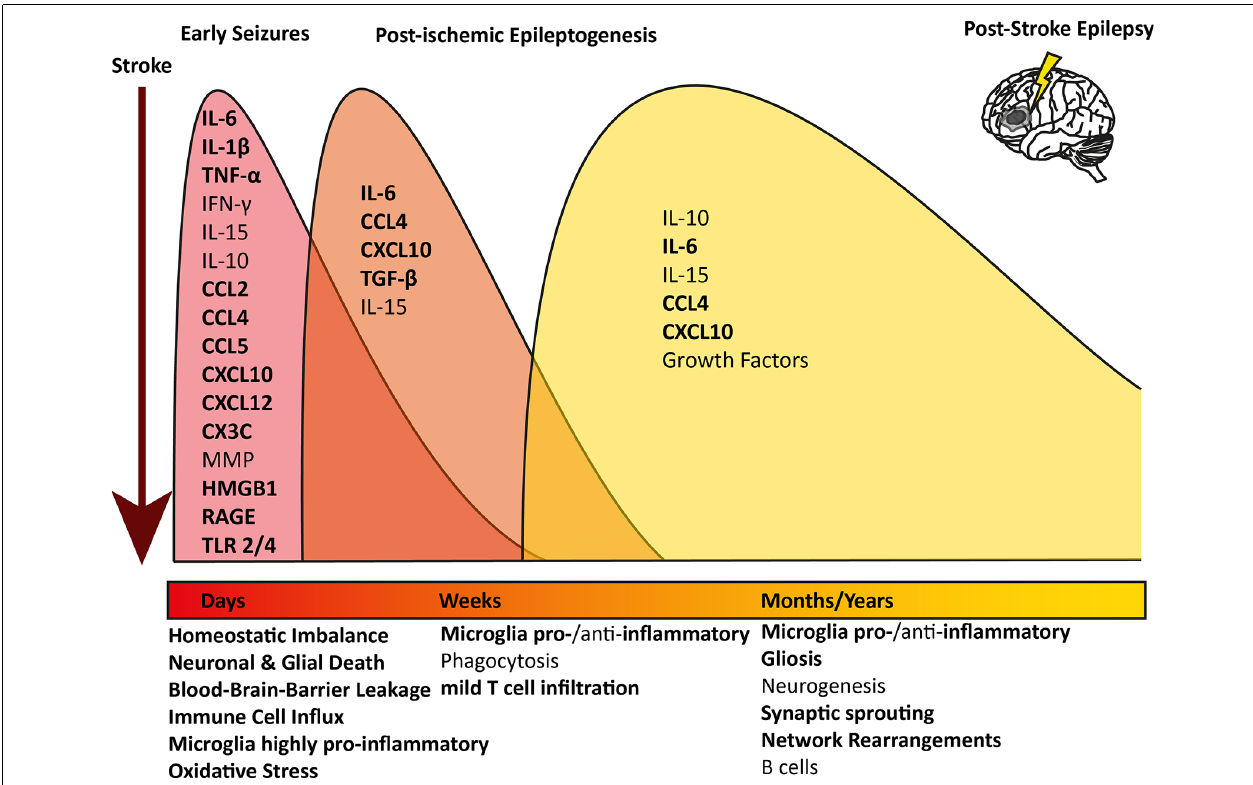
FIGURE 1 | Overview of longitudinal inflammatory changes after ischemic stroke: pathophysiological mechanisms and contributing inflammatory mediators are indicated at the respective time point after an ischemic infarct. The timely progression and difference of the inflammatory profile at the different stages after stroke are indicated in different colored waves. All pathophysiological mechanisms and inflammatory mediators contributing to epilepsy too are indicated in bold. IL, Interleukin; TNF, Tumor necrosis factor; IFN, Interferon; MMP, Metalloproteinases; HMGB1, High-mobility group box 1; RAGE, receptor for advanced glycation products; TLR, Toll-like receptor.